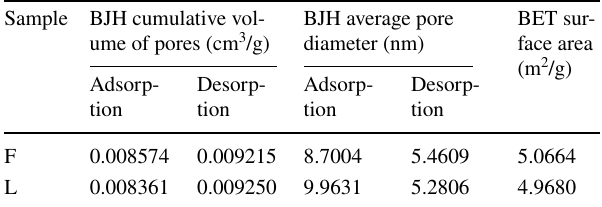
Table 3 Pore structure parameters of the samples Sample BJH cumulative vol- ume of pores (cm 3 /g)